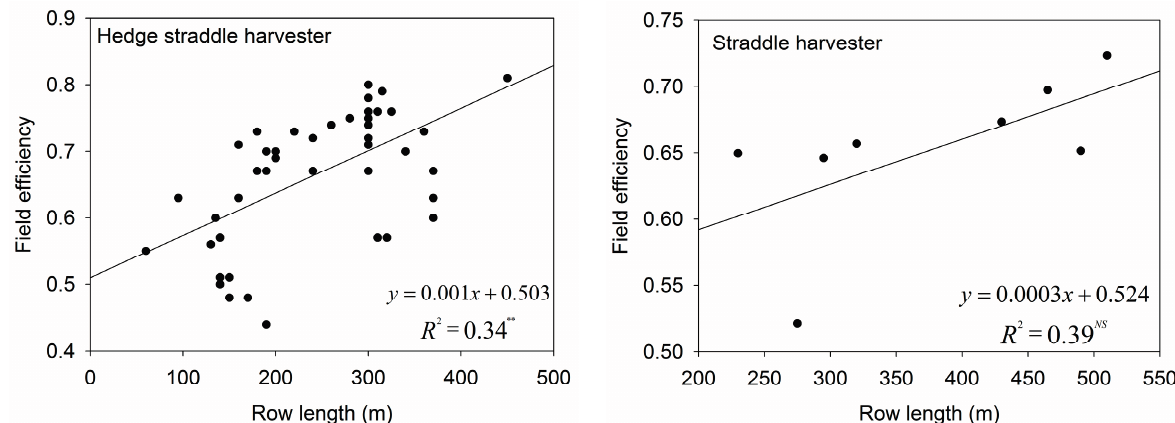
Figure 4. Trend between the effective field capacity and row length for both the hedge straddle harvester ( Left ) and the straddle harvester ( Right ).